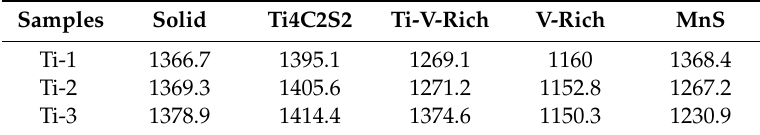
Table 2. Precipitation temperature of the phases, °C.